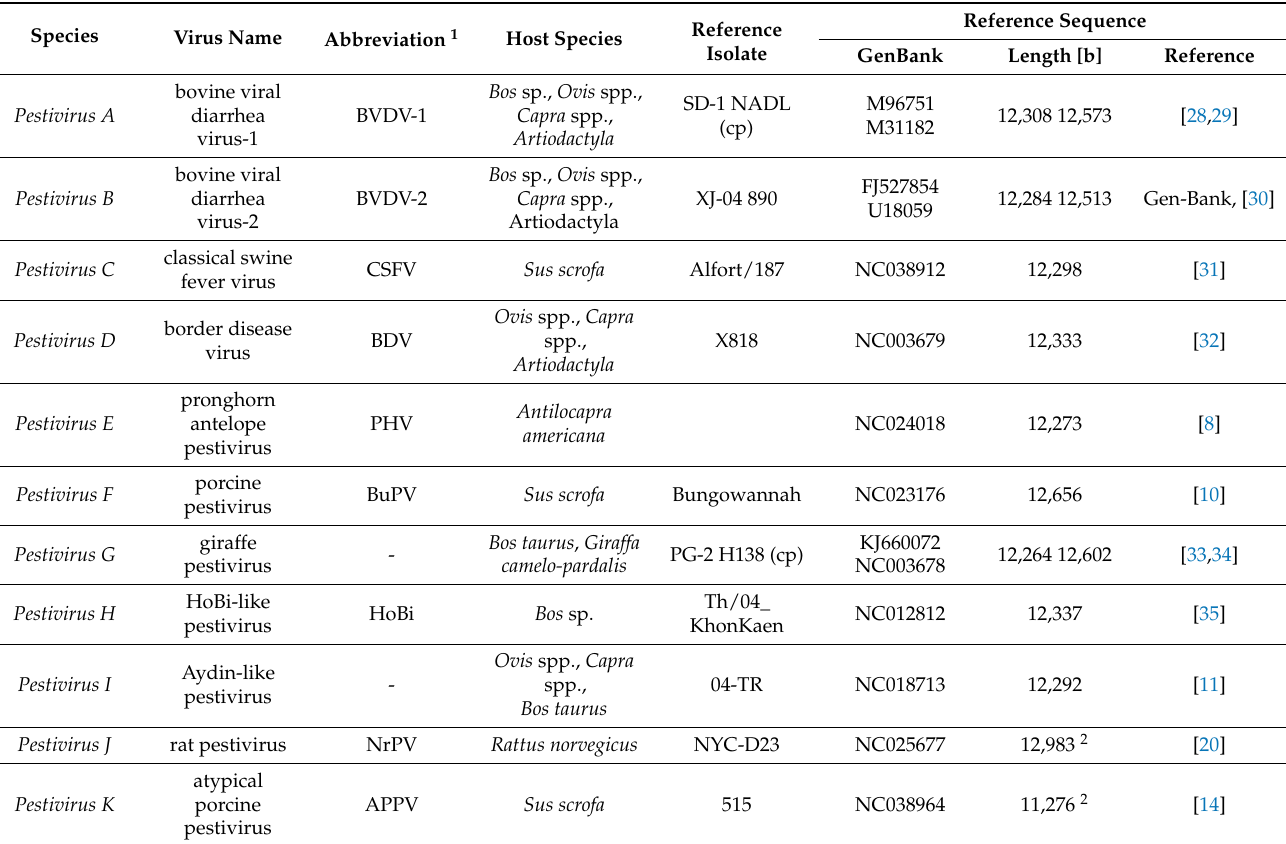
Table 1. Established pestivirus species and reference